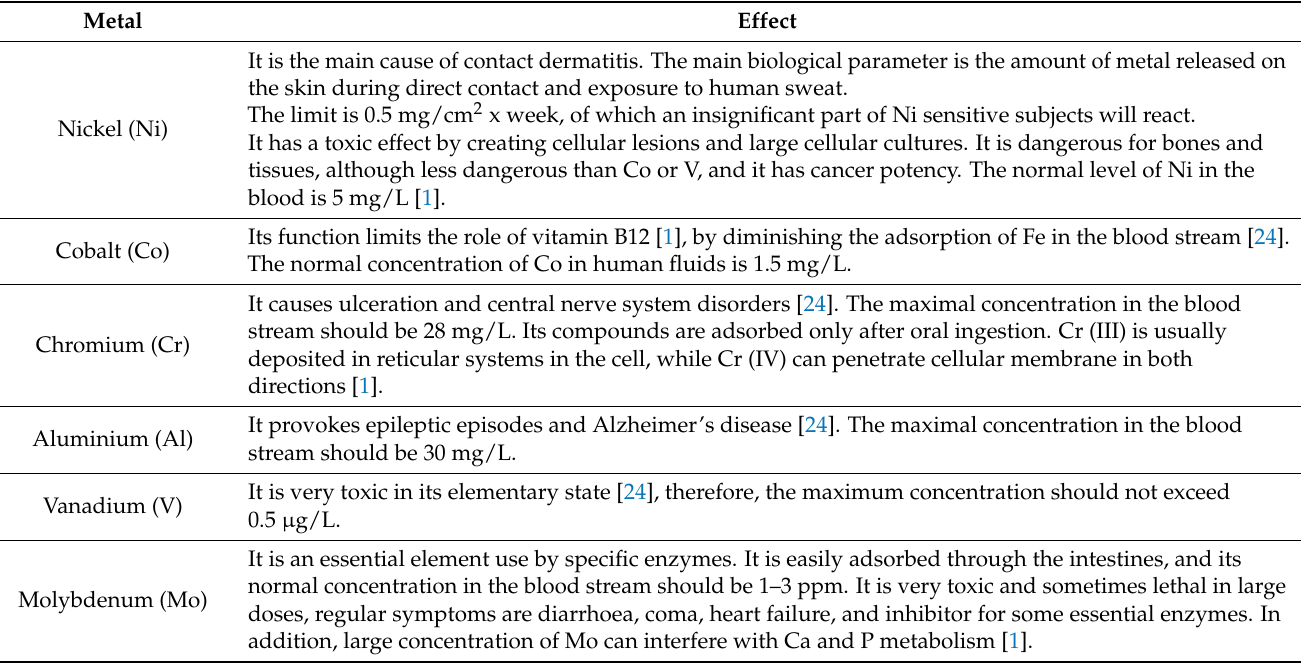
Table 5. Biological effects and maximal concentrations of metal ion accumulation in the human